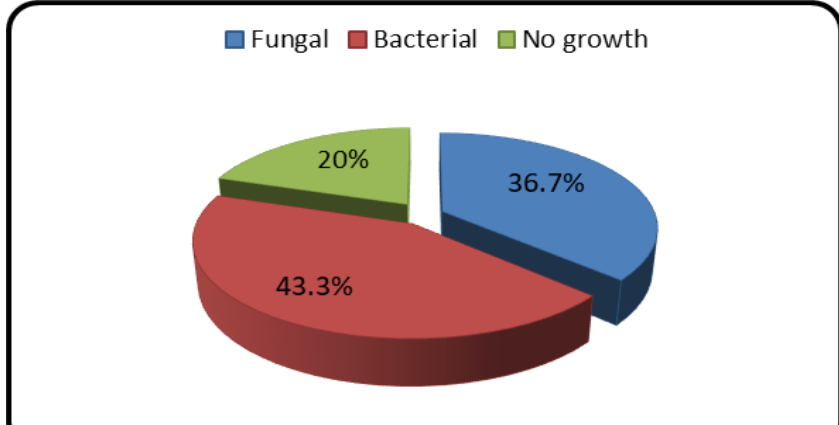
Figure 7. Distribution of culture isolates among corneal ulcer